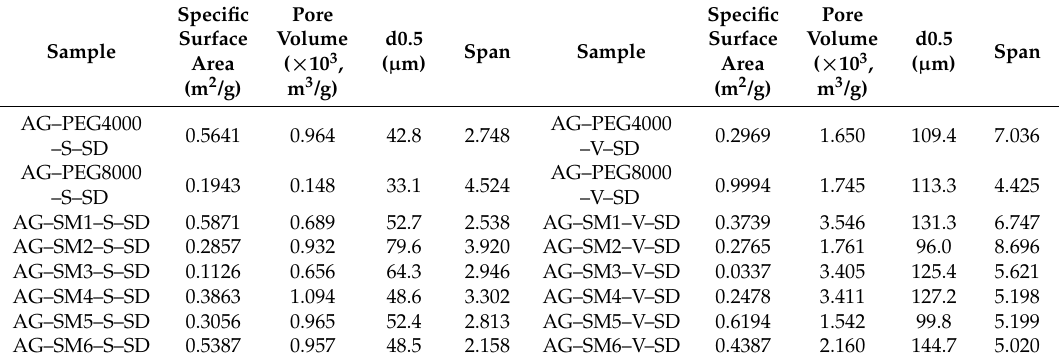
Table 3. Specific surface area, pore volume, particle size, and distribution of solid dispersions.